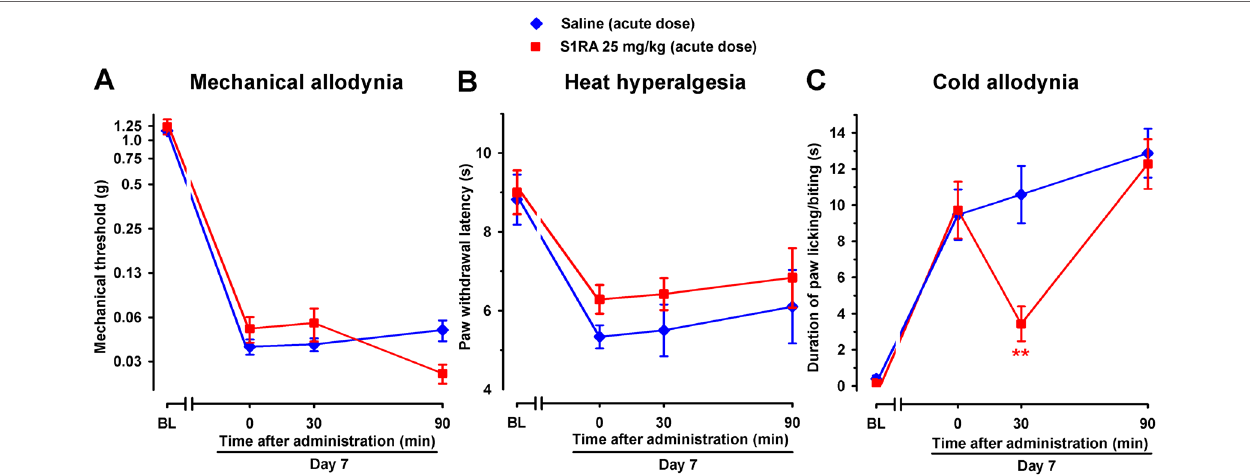
FIGURE 11 | Time course of the effects of a single i.p. injection of S1RA (25 mg/kg) or saline on mechanical allodynia (A) , heat hyperalgesia (B) , and cold allodynia (C) in female WT mice with SNI 7 days after surgery. Responses were recorded in each animal before SNI (baseline, BL) and 7 days (day 7) after surgery. On day 7 the responses to test stimuli in the paw ipsilateral to the surgery were recorded immediately before (time 0) and at two times (30 and 90 min) after injection of the drug or saline. Each point and vertical line represent the mean ± SEM of the values obtained in six to eight animals. Statistically significant differences between S1RA- and saline-treated groups at the same time after treatment: ** P < 0.01 (two-way repeated-measures ANOVA followed by Bonferroni test).